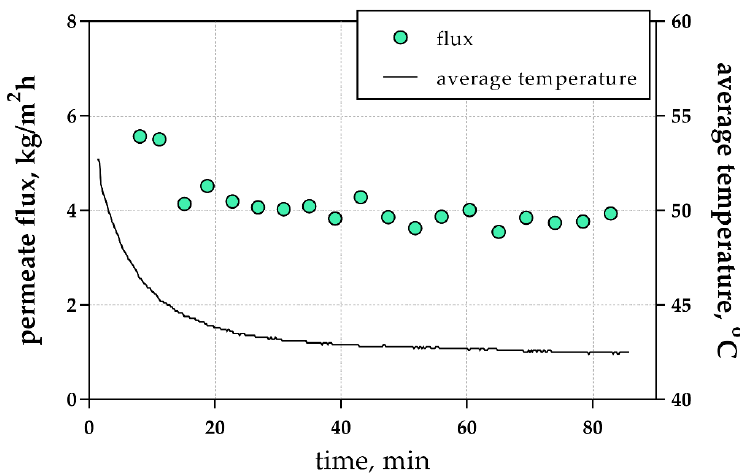
Figure A1. Permeate flux and average feed temperature versus the experiment time. Test with deionized water.